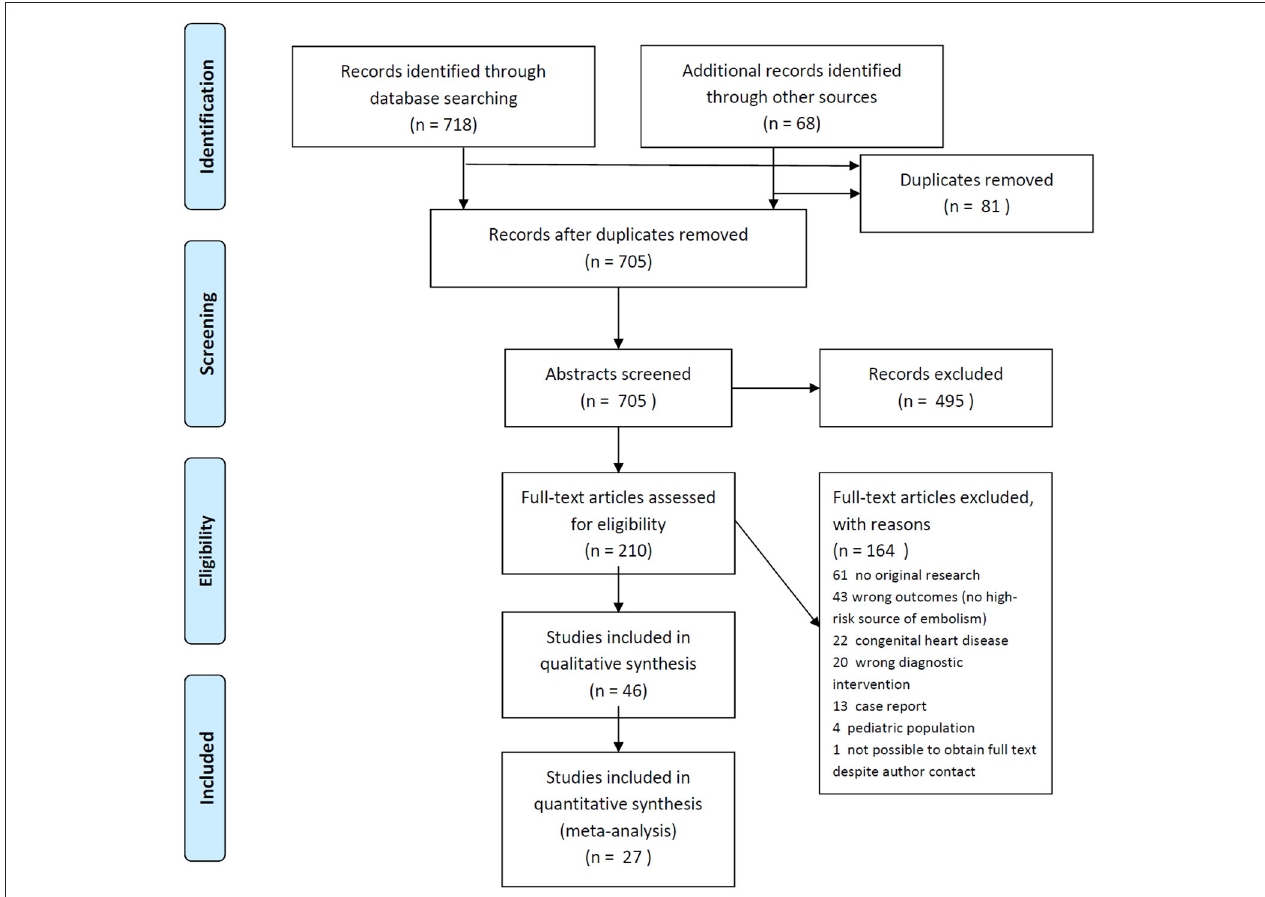
FIGURE 1 | PRISMA flow